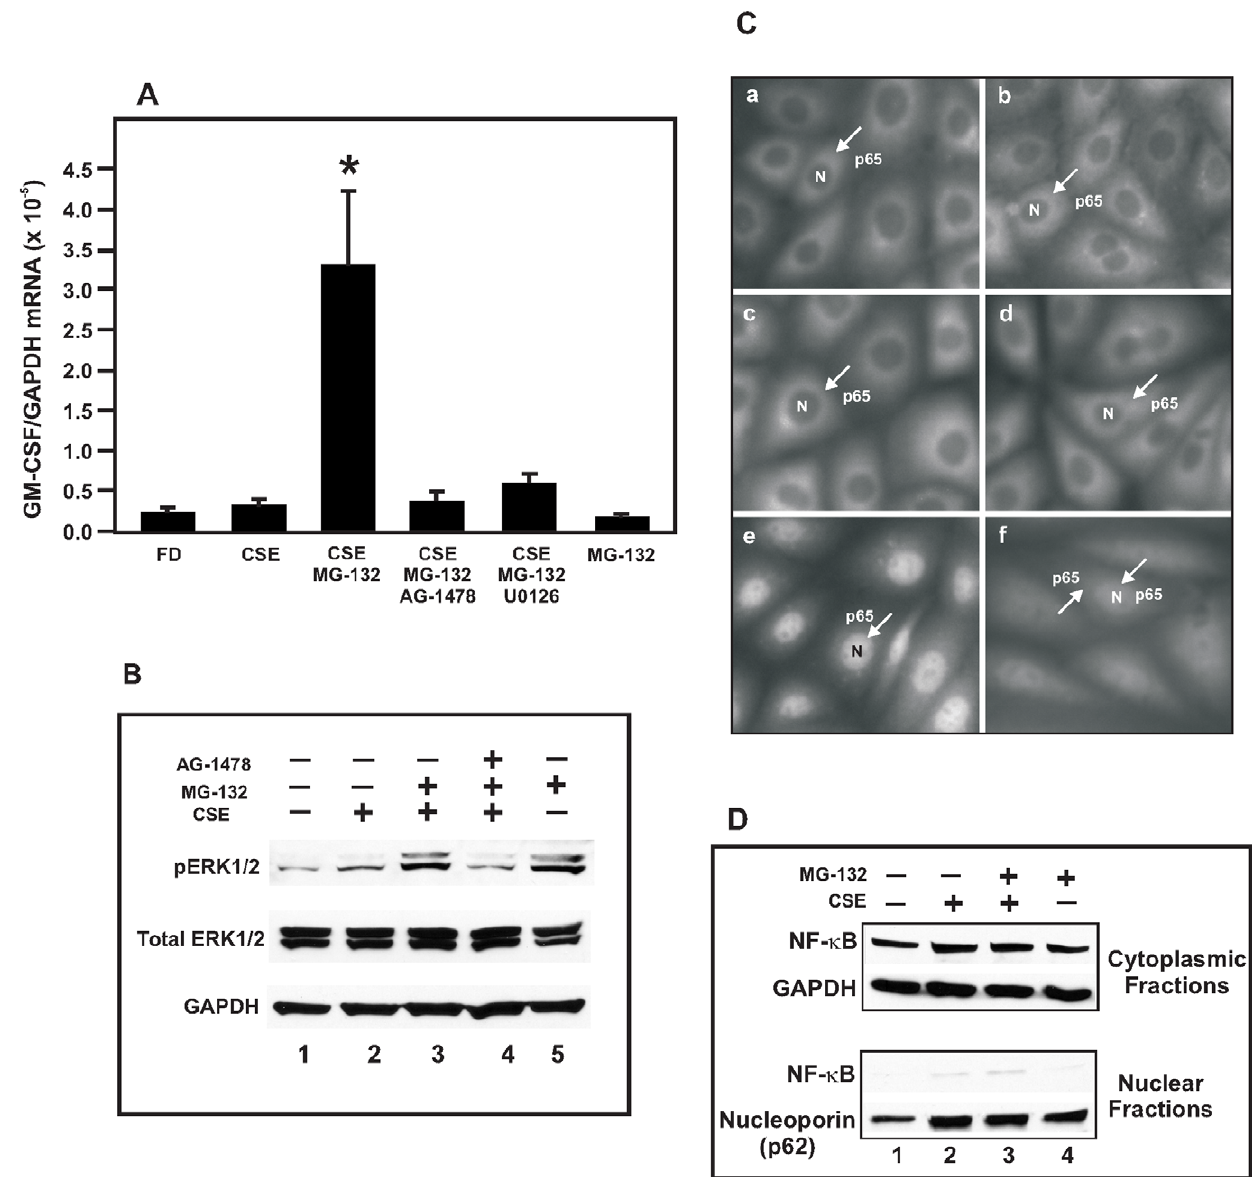
Figure 3. Effects of inhibitors on CSE-induced GM-CSF mRNA expression. (A) Changes of GM-CSF mRNA expression level in B6Tert-1 cells treated with different agents in FD medium. CSE: 10% cigarette smoke extract; MG-132: proteasome inhibitor at 5 m M; AG-1478: EGFR kinase inhibitor at 5 m M; U0126: MEK inhibitor at 5 m M. Cells were pre-treated with inhibitor(s) for 30 min, and then with 10% CSE for another 5 h. DMSO was used as a vehicle control. The asterisk (*) indicates a statistically significant difference ( p , 0.05) when compared with CSE-treated cells. (B) Western blot analysis of the phosphorylation state of ERK1/2 in B6Tert-1 cells treated with 10% CSE without or with inhibitors (5 m M each) as indicated for 30 min. Total ERK1/2 and GAPDH were used as the total protein and loading controls. Lane 1: FD (no treatment); lane 2: 10% CSE; lane 3: 10% CSE/MG-132; lane 4: 10% CSE/MG-132 and AG-1478; lane 5: MG-132 alone. The image represents one of three independently performed experiments. (C) Immunofluorescent staining showing the cellular distribution of NF- k B p65 subunit in B6Tert-1 cells under different treatment conditions. a: FD alone; b: 10% CSE; c: 10% CSE/MG-132; d: MG-132 alone; e: TNF- a : 50 ng/ml; and f: TNF- a /MG-132. ‘‘N’’ indicates the nucleus and the arrow indicates the NF- k B p65 subunit staining. Magnification: 20 6 10. (D) Western blot analysis of the distribution of NF- k B p65 subunit in B6Tert-1 cells under different treatment conditions. Cytoplasmic proteins were blotted with antibodies against NF- k B and GAPDH while nuclear proteins were blotted with antibodies against NF- k B and nucleoporin p62. Lanes 1: FD (no treatment); lanes 2: 10% CSE; lanes 3: 10% CSE/MG-132; and lanes 4: MG-132 alone. The image represents one of three independently performed experiments.